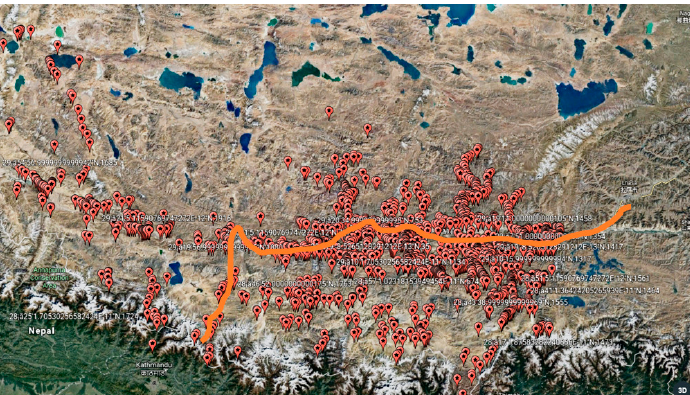
Figure 6. Sample points of test area.